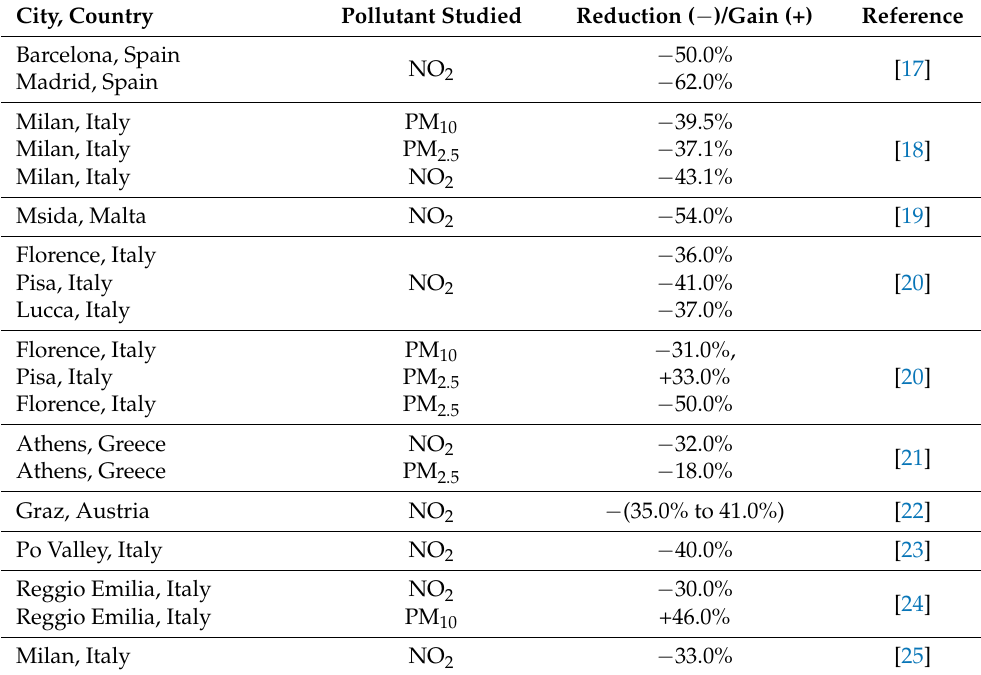
Table 1. Changes in NO 2 and particulate matter levels during the COVID-19 lockdown period in 2020 over several European and UK